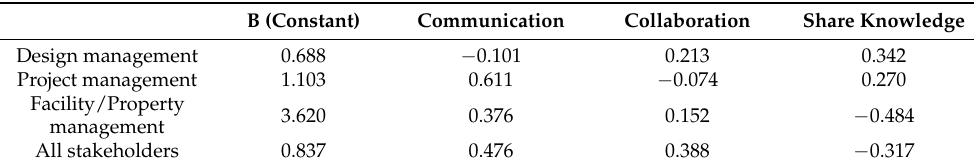
Table 5. The influence on design performance in forming optimum space value. B